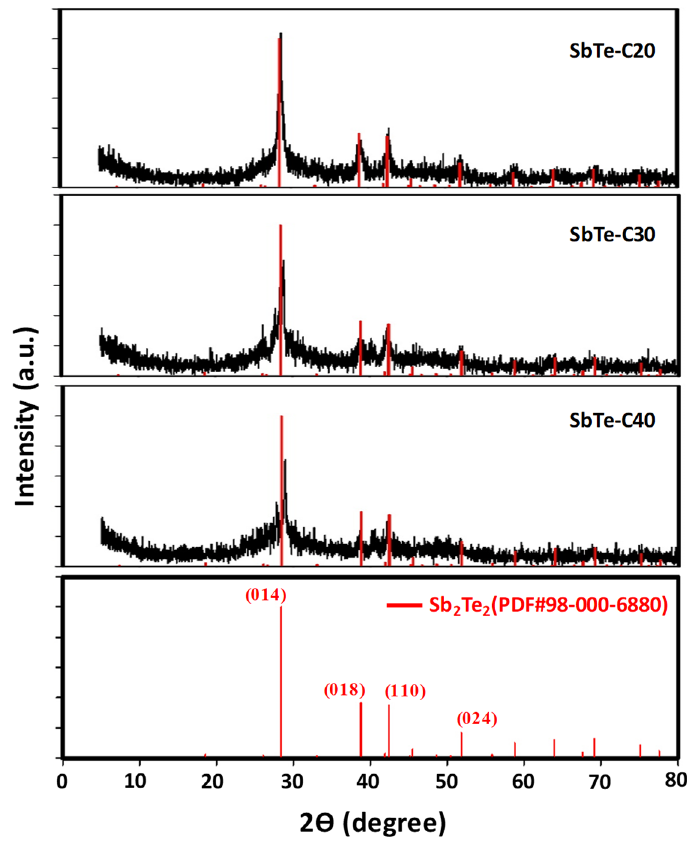
Figure 1. XRD patterns of the as-prepared SbTe-C20, SbTe-C30, SbTe-C40 composites.